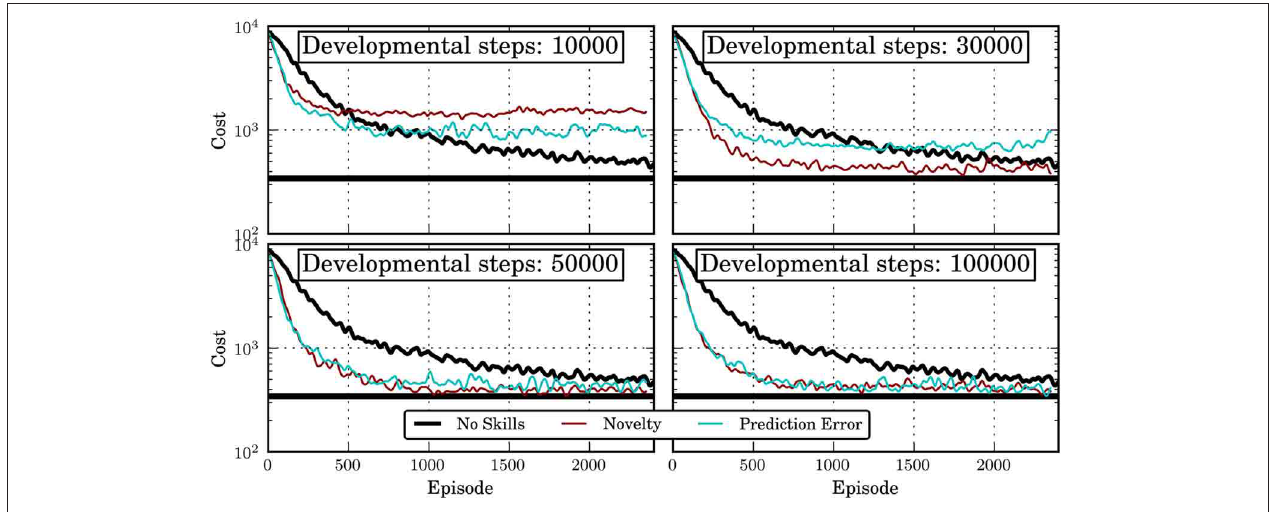
FIGURE 7 | Cost (negative return) of IMRL agent in the 12 tasks 2D Multi-Valley domain for different intrinsic motivation systems and different lengths of the developmental period. “No Skills” shows the performance of a monolithic agent that does not learn skills and has no